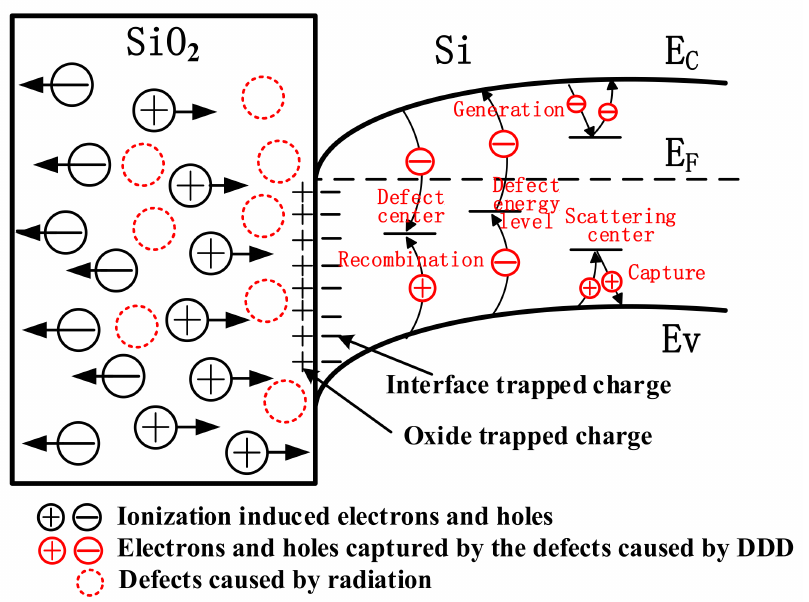
Figure 9. Distribution of charge in N-channel MOSFET induced by the synergistic effect of gamma-ray and